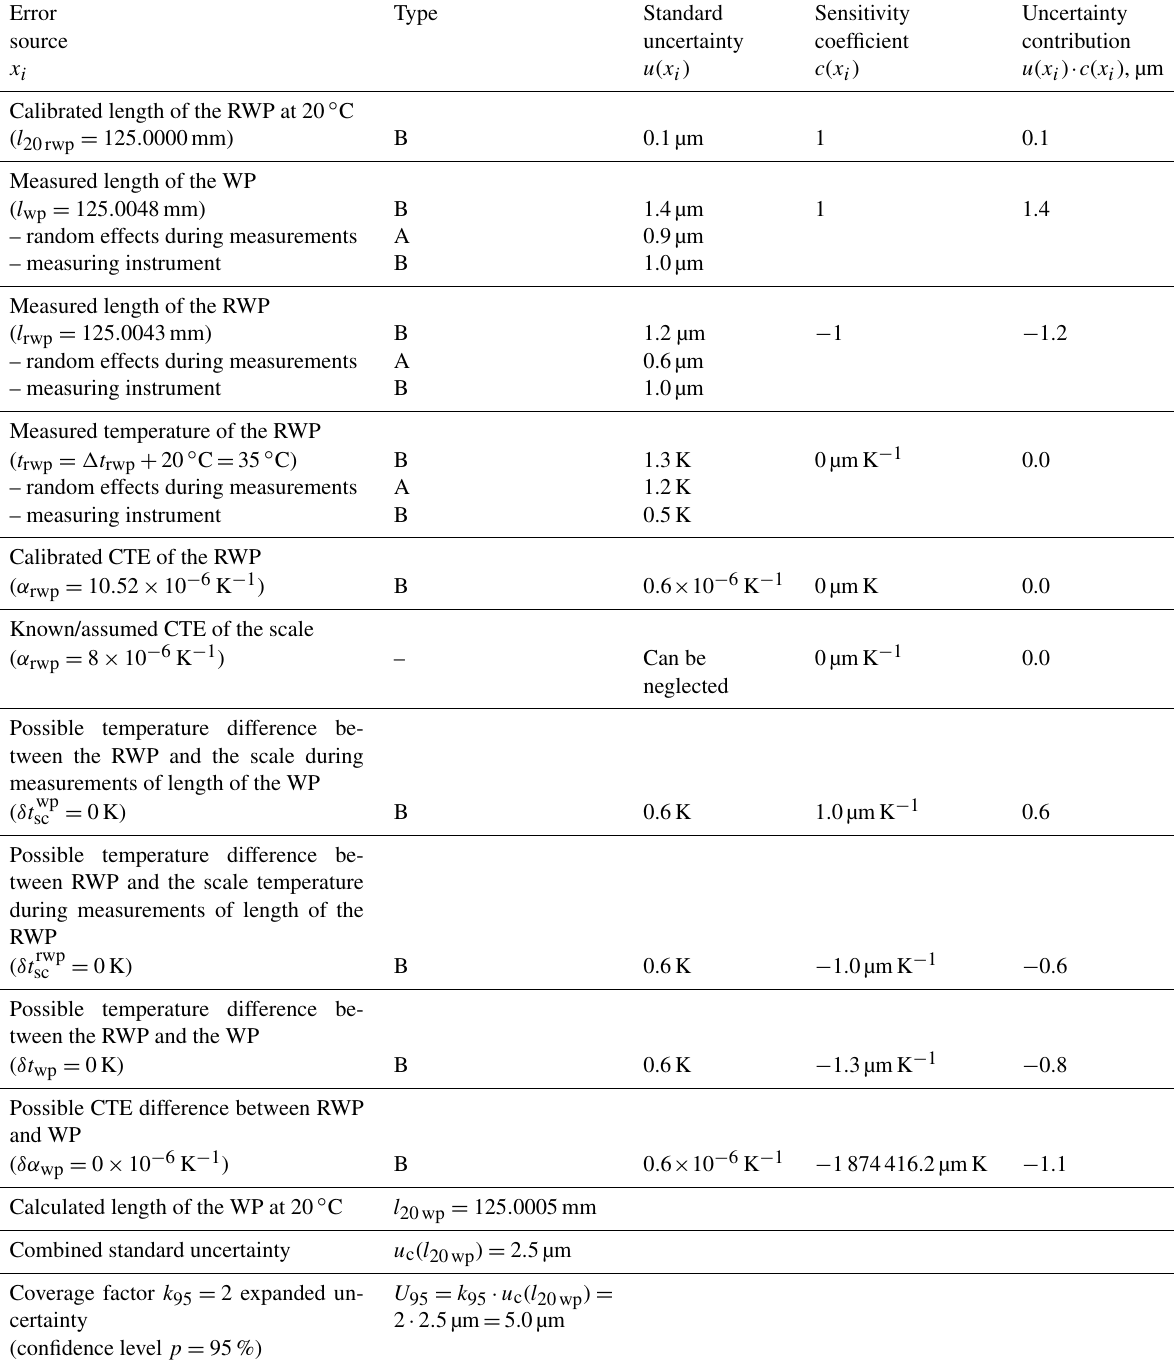
Table 1. Uncertainty budget for example